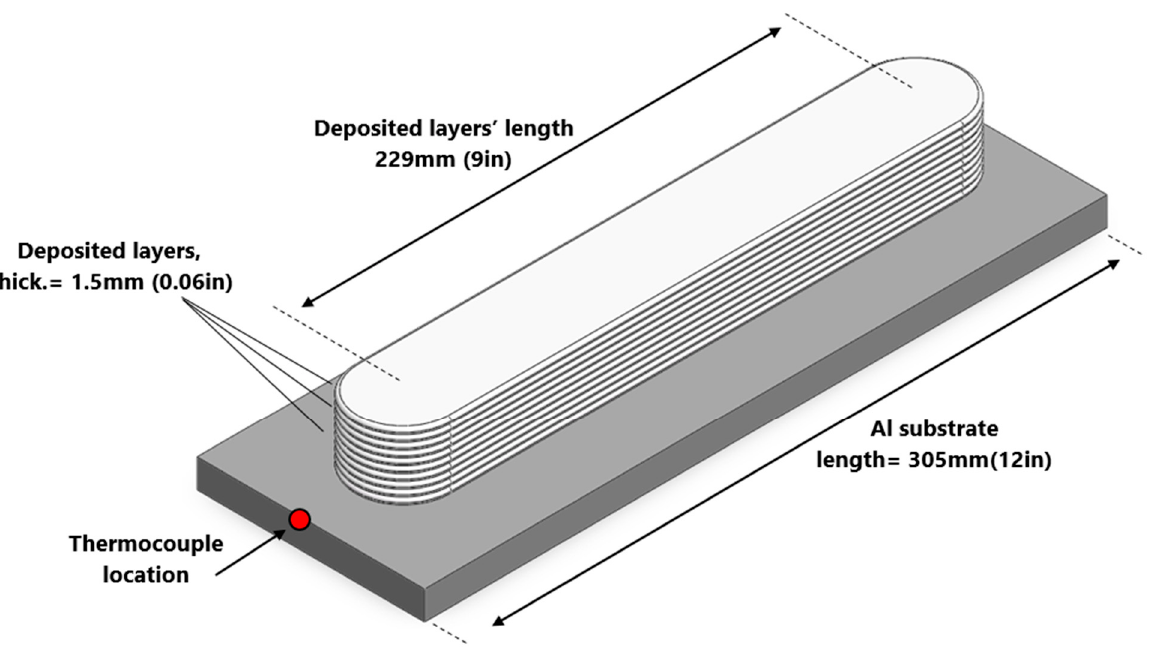
Figure 8. Deposited block geometry and the thermocouple placement to read the temperature during the deposition.